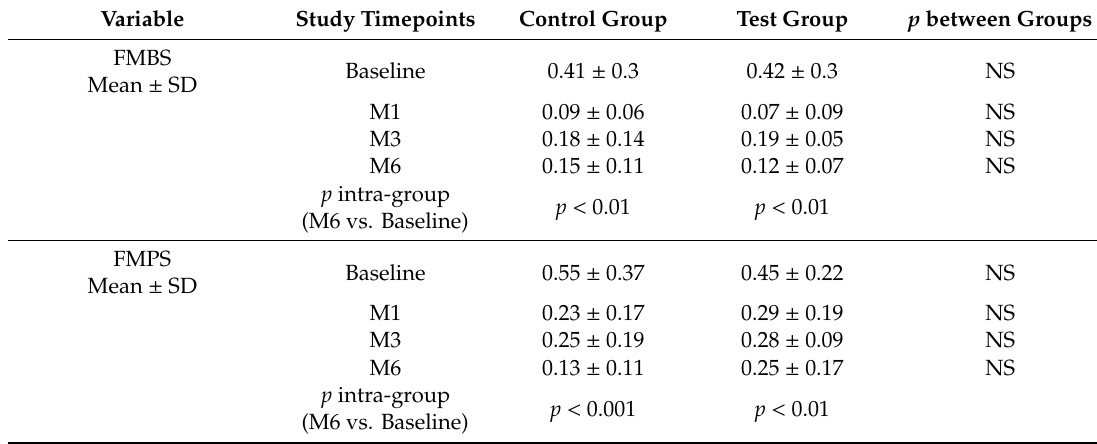
Table 4. Clinical